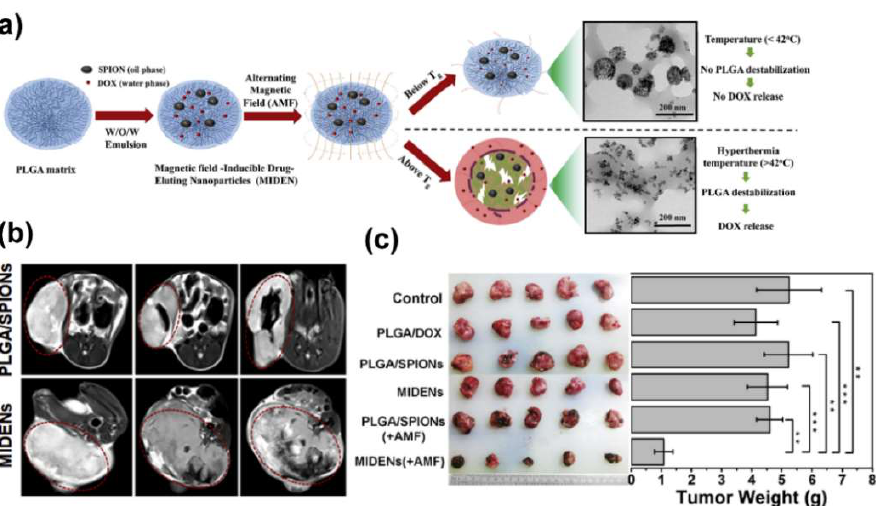
Figure 7. ( a ) Schematic illustration showing the formation of magnetic field inducible drug–eluting nanoparticles (MIDENs). ( b ) T2 MRI of CT26 xenografted mice administered intratumorally with PLGA/SPIONs and MIDENs (10 mg [Fe] /kg body weight). Tumor regions are marked with a red circle. ( c ) Photographs of tumor tissues and weights of tumors collected 15 days post treatment ( n = 5). The statistical significance was evaluated using Student ’ s t –test. ** p < 0.01, *** p < 0.001. Reprint with permission from [126]. Copyright 2018 Elsevier Ltd. , Amsterdam, The Netherlands.